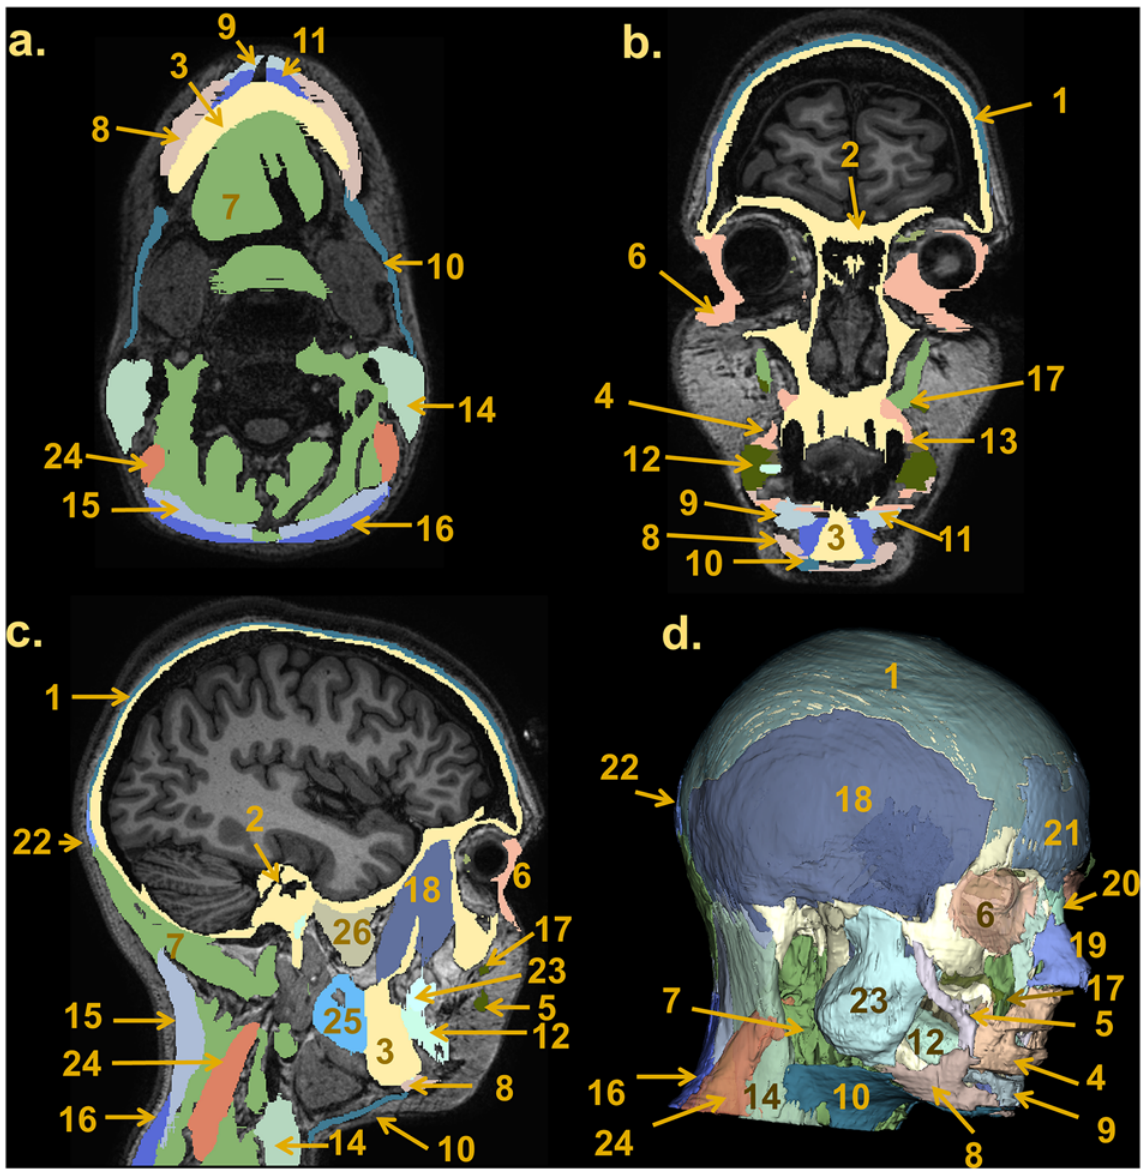
Fig 14. Segmentation of muscles. Axial (a), coronal (b) and sagittal (c) views of the individual and general muscle labels in the T1-weighted dataset. (d) Right anterior oblique view of the 3D reconstruction of the muscles. Legend of the structures: 1 Galea aponeurotica (tendon), 2 Skull, 3 Mandible, 4 Orbicularis oris, 5 Zygomaticus major, 6 Orbicularis oculi, 7 Muscles (general), 8 Depressor anguli oris, 9 Depressor labii inferioris, 10 Platysma, 11 Mentalis, 12 Buccinator, 13 Risorius, 14 Sternocleidomastoid, 15 Splenius capitis, 16 Trapezius, 17 Zygomaticus minor, 18 Temporalis & temporoparietalis, 19 Nasalis, 20 Procerus, 21 Occipitofrontalis frontal belly, 22 Occipitofrontalis occipital belly, 23 Masseter, 24 Levator scapulae, 25 Medial pterygoid, 26 Lateral